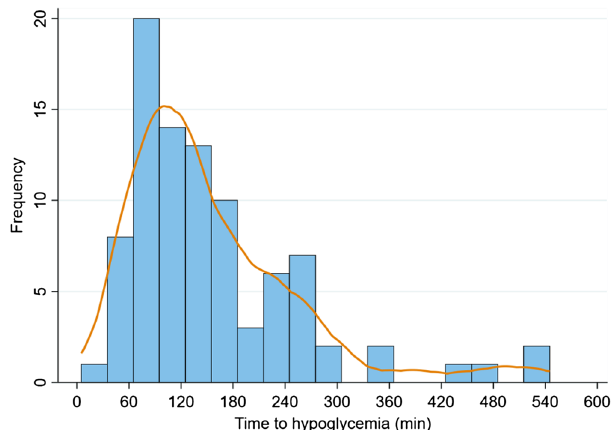
Figure 3. Timing of hypoglycemia after insulin-dextrose treatment (n = 90). Kernal density line (dark orange) highlights the peak occurrence of hypoglycemia at around 90 min after treatment was given. Additional hypoglycemia events occurred after the mandatory 6 h monitoring in patients who received a second treatment. Only two patients who received a single treatment experienced hypoglycemia after 5